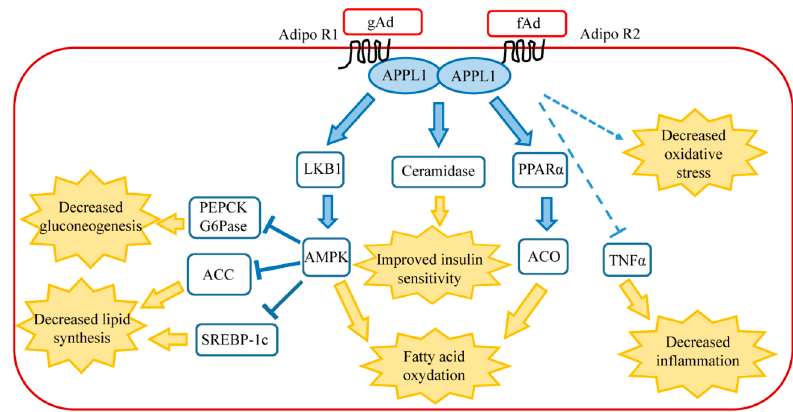
Figure 1. Main signaling pathways of adiponectin in healthy liver. AdipoR1 activates AMPK pathway, whereas AdipoR2 activates peroxisome proliferator-activated receptor α (PPAR α ). Connections between AdipoR1/AdipoR2 signaling, TNF α , ceramide, and oxidative stress are described in the text. The final biological effects of each signaling pathway are shown following the yellow arrows. Abbreviations: ACC, Acetyl-CoA carboxylase; ACO, Acyl CoA oxidase; AdipoR1, Adiponectin receptor 1; AdipoR2, Adiponectin receptor 2; AMPK, AMP-activated protein kinase; APPL1, adaptor protein phosphotyrosine interaction, pH domain, and leucine zipper containing 1; fAd, full-length adiponectin; gAd, globular adiponectin; G6Pase, glucose 6-phosphatase; LKB1, liver kinase B1; PEPCK, phosphoenolpyruvate carboxykinase; PPAR α , peroxisome proliferator-activated receptor α ; SCREB-P1c, sterol regulatory element binding protein 1c; TNF α , tumor necrosis factor α .